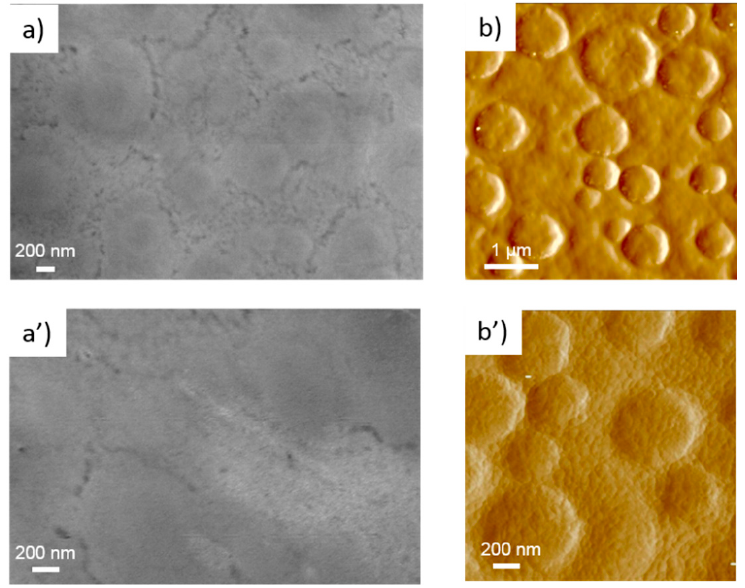
Figure 3. ( a ) SEM image; ( a’ ) magnified SEM image; ( b ) AFM phase image; ( b’ ) magnified AFM phase image of the sintered printed ZnO seed layer obtained after 4 h of treatment. NWs were grown by a CBD method on both types of printed ZnO seed